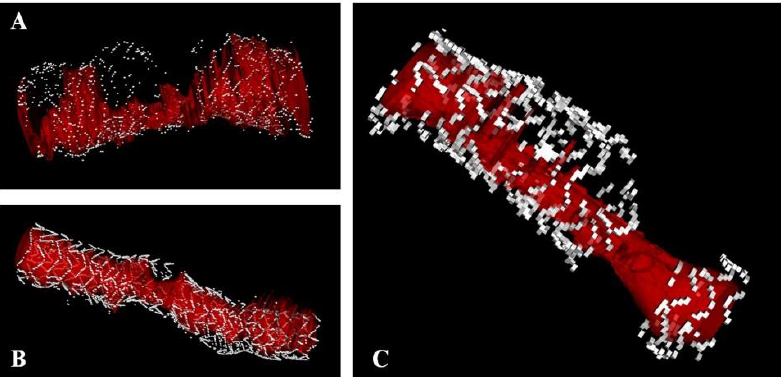
Figure 5. Three examples of the spatial relationship between restenosis/thrombosis and strut fracture. The figure presents three cases of pattern 4 (( A , B ): DES; ( C ): BRS) fracture associated with device failure (( A ): thrombosis; ( B , C ): restenosis). The residual vessel lumen is presented in red.